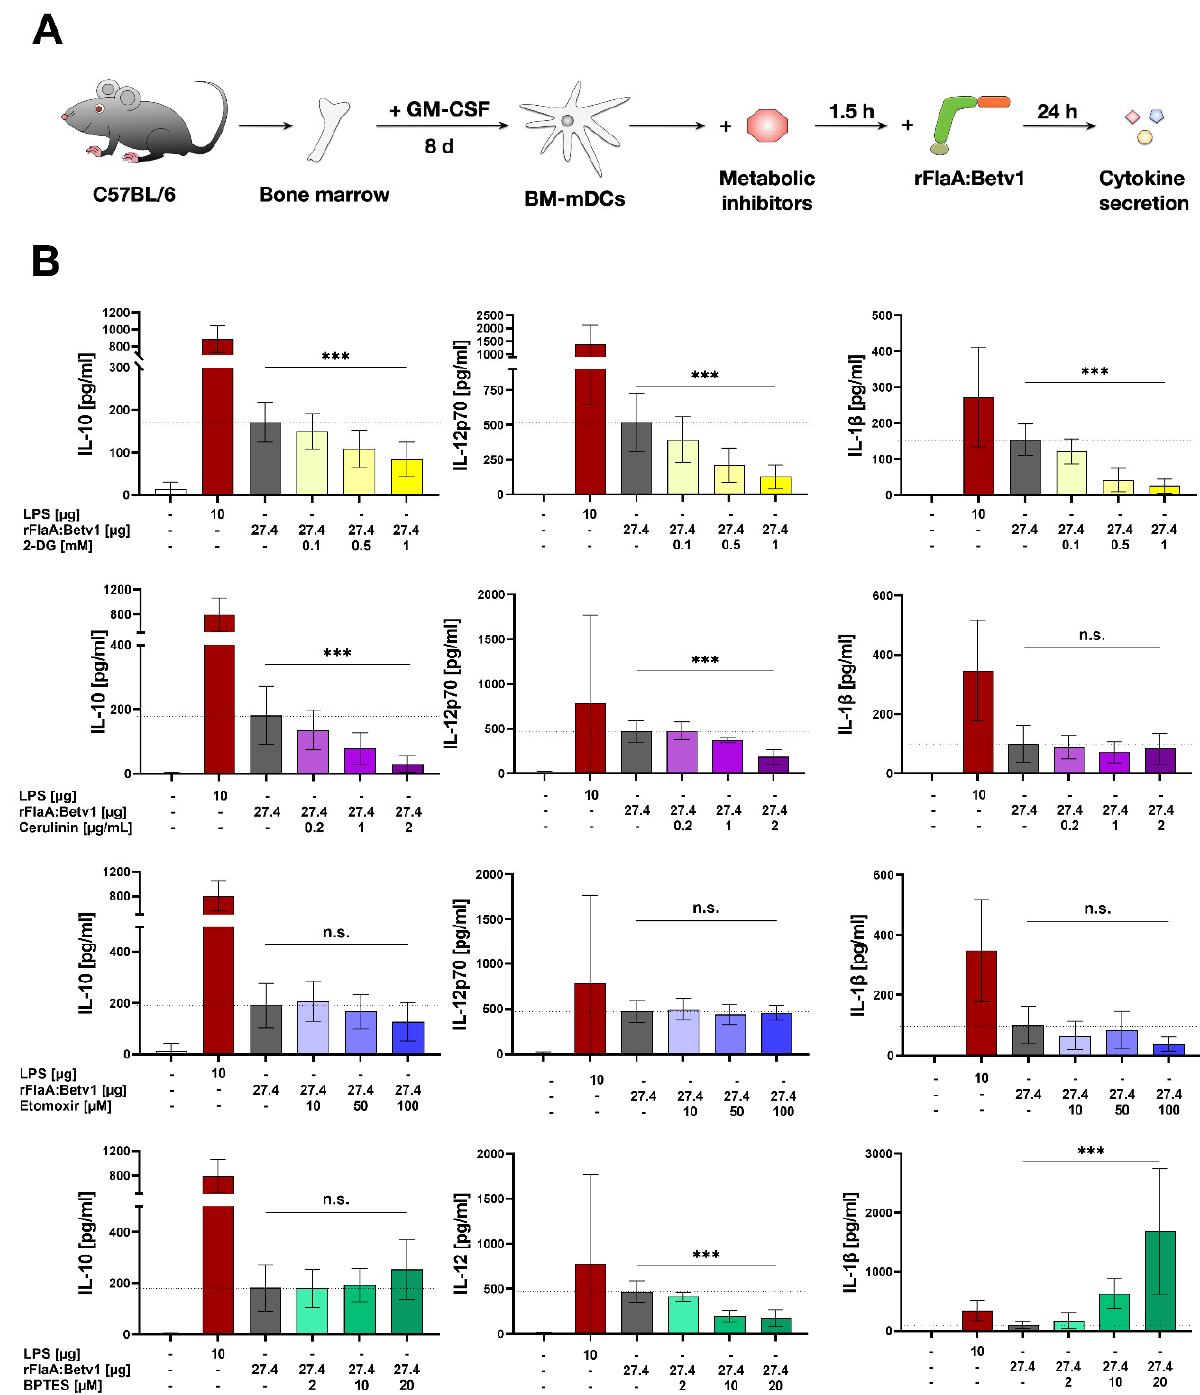
Figure 3. rFlaA:Betv1-induced IL-10 secretion from mDCs depends on glycolytic metabolism and fatty acid synthesis. mDCs were pretreated for 90 min with the indicated inhibitor concentrations followed by stimulation with 27.4 µg/mL of rFlaA:Betv1 for 24 h ( A ). Supernatants were analyzed for cytokine secretion by ELISA. Data are mean results of three to four independent experiments ( B ). Statistical comparisons were performed by 2-way ANOVA with correction for multiple comparisons according to Tukey and indicated as: n.s. p -value > 0.05, or *** p -value < 0.001. Please note that data shown in Figures 4 and 5 were generated using the same mDC